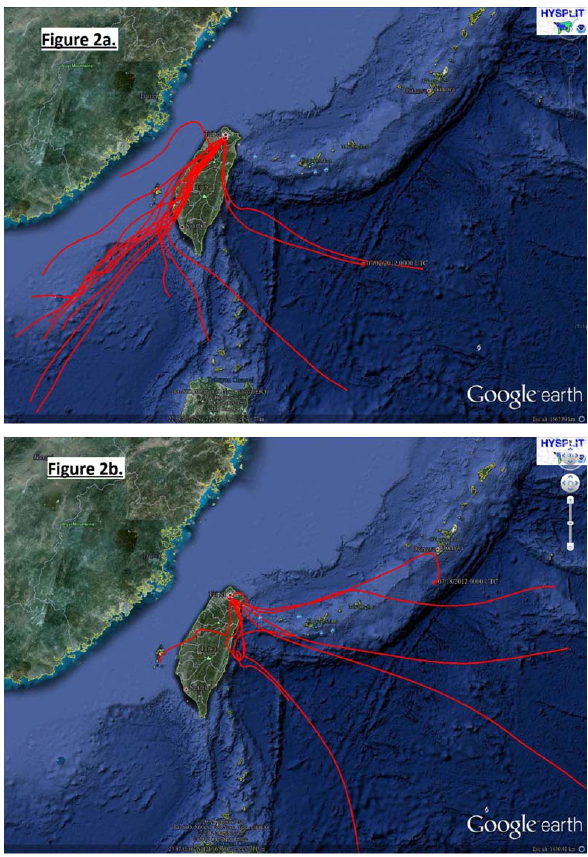
Fig. 2. Daily 72h backward trajectories calculated for TARO (red dot) during the period of (a) 4–19 July and (b) 20–27 July 2012. Trajectories were calculated from 100m above ground level for 08:00LT each